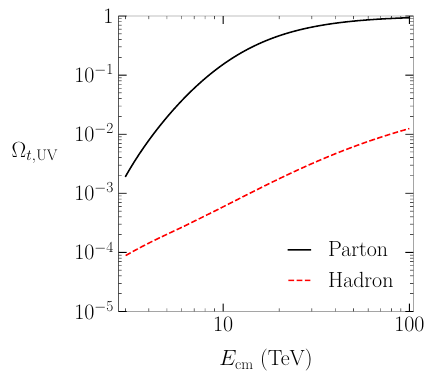
Figure 4 . Ω t, UV computed using the t -channel UV model as a function of the center-of-mass energy E cm for parton and hadron initial states. This shows that the UV theory is free of perturbative unitarity violation, when the couplings are taken to be λ qφ = | µ qφ | 2 /M 2 = 8 π .